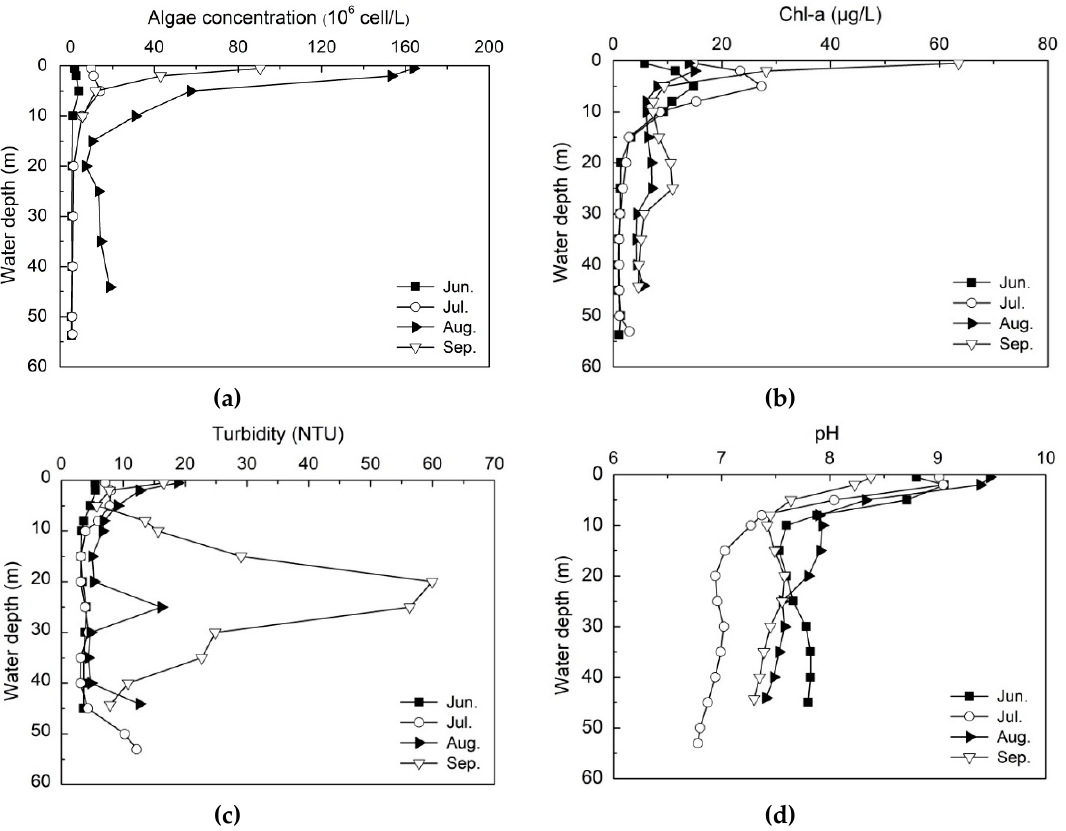
Figure 6. Seasonal algae concentration ( a ), chlorophyll a ( b ), pH ( c ), turbidity ( d ) depth profiles of S1 site in Lijiahe Reservoir from June to September in 2017.